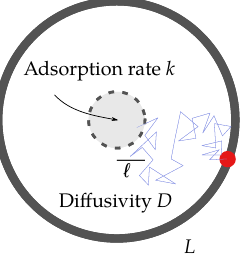
Figure 2. Sketch of the toy model. The particle (red dot) diffuses with a diffusion constant D > 0 in a circular domain of radius L > 0, searching for the active zone of radius (cid:96) (0 < (cid:96) < L ). One example trajectory is depicted by the blue line. Within the active zone, the particle can get absorbed at rate k > 0. For the target problem of this work, the particle can be thought of as the ligand-bound receptor RS finding the G protein, but it is moving with the combined diffusion